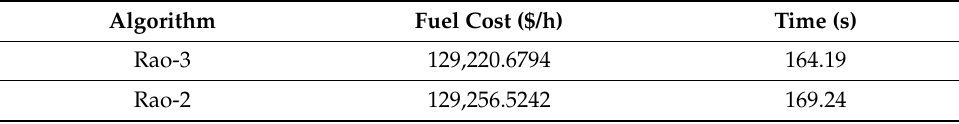
Table 18. Case 11 (FCM) results in the IEEE 118-bus